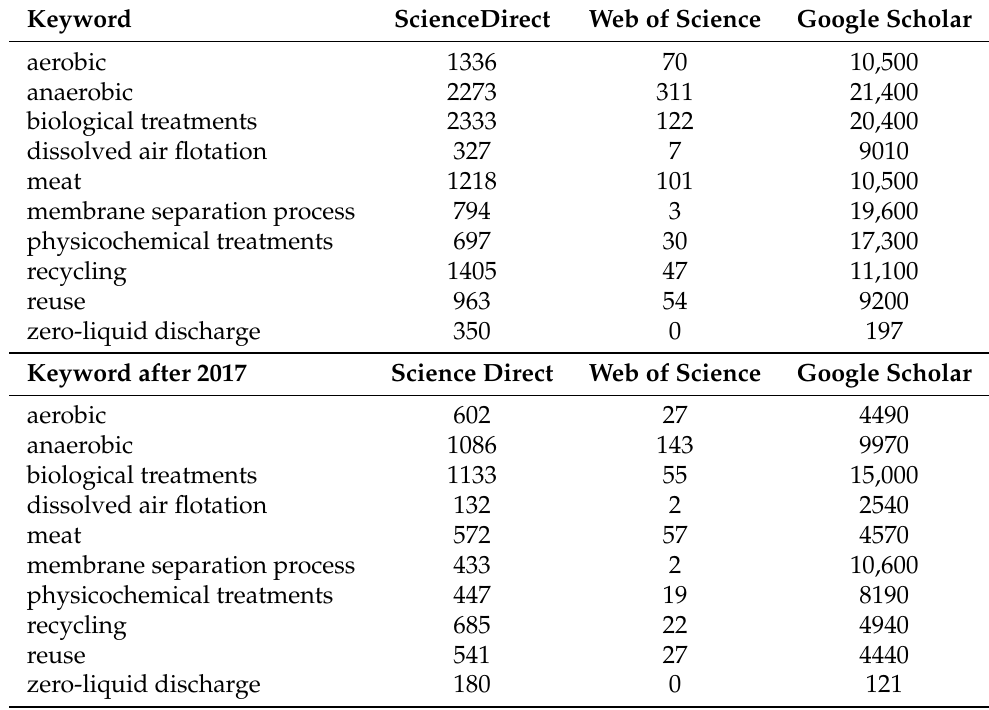
Table 2. Keyword search hits in combination with